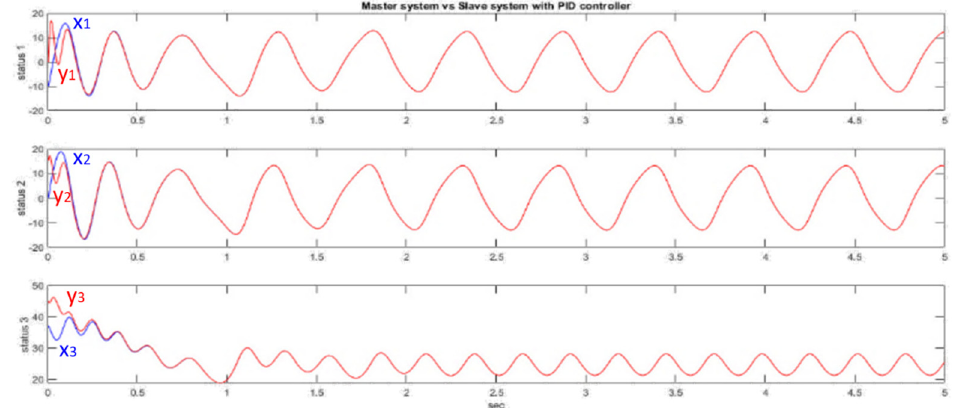
5 of 16 Figure 4. Response to different initial values.